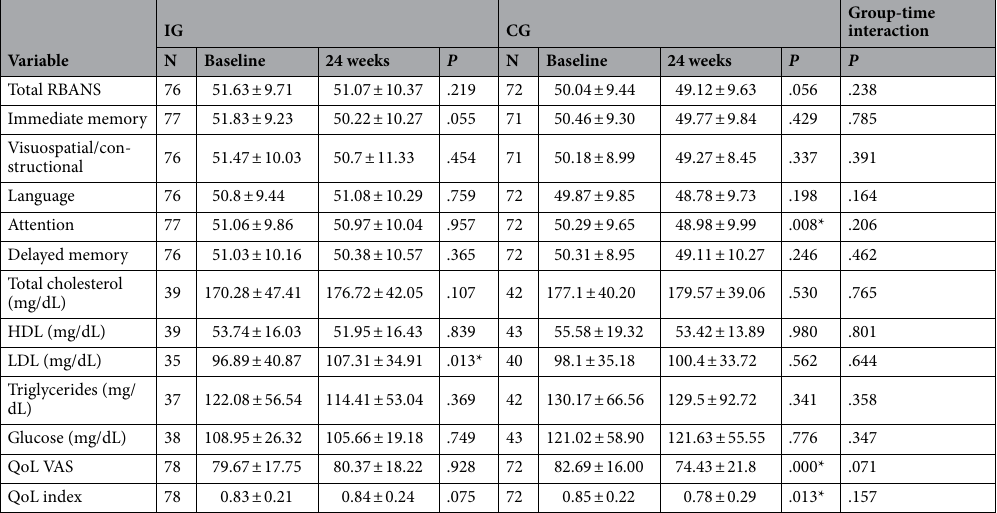
Table 4. Cognitive, EQ-5D QoL and blood tests: effect of the multi-domain intervention programme within and between groups. Data presented in mean ± SD. * P <